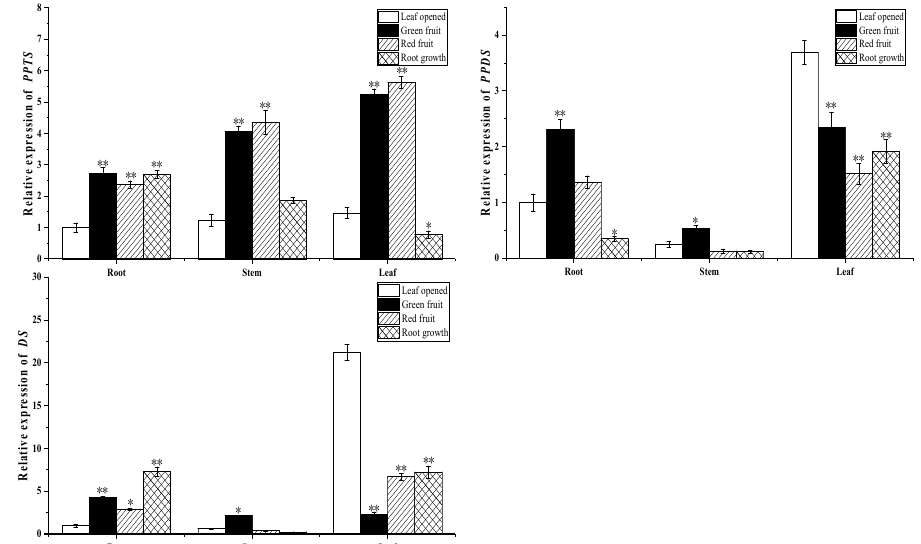
Figure 7. Expression of genes related to ginsenoside biosynthesis in roots, stems, and leaves during different growth times. The relative expression of ( A ) PPTS, ( B ) PPDS, and ( C ) DS genes in the leaf opened, green fruit, red fruit, and root growth stages was analyzed by real-time polymerase chain reaction. Vertical bars indicate the mean ± standard error from three independent experiments. * indicated that the different growth stages are significantly different at the 0.05 level. ** indicated that the different growth stages are significantly different at the 0.01 level.